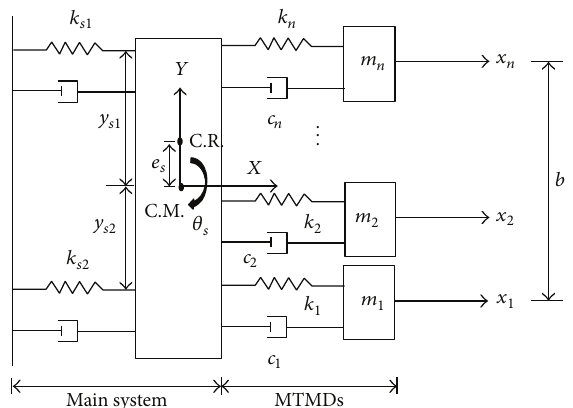
Figure 7: The multiple tuned mass damper (MTMD).